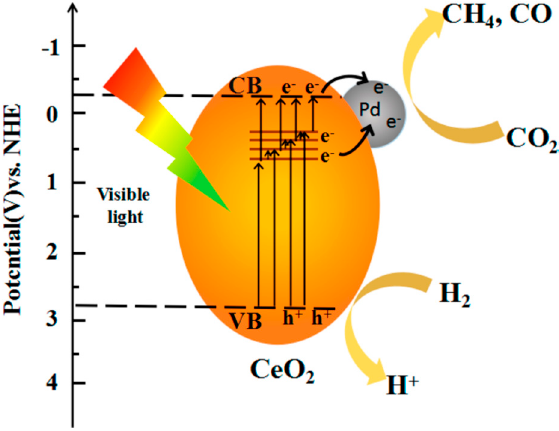
Figure 5. Band energy structure and charge transfer [34]. Copyright 2017 American Chemical Society.